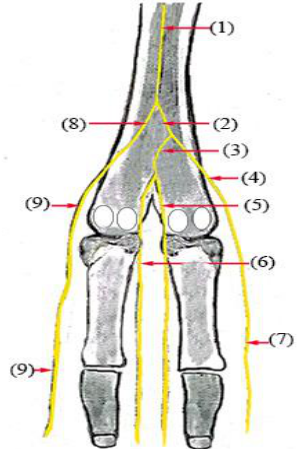
Figure 6. Nerve supply of the plantar surface of the distal hindlimb in camels: (1) tibial nerve; (2) medial plantar nerve of the IV digit; (3) axial plantar proper digital nerve of the III digit; (4) abaxial plantar proper nerve of the III digit; (5) axial plantar proper nerve of the III digit; (6) axial plantar proper nerve of the IV digit; (7) abaxial plantar proper nerve of the III digits; (8) lateral plantar nerve of the IV digit; (9) abaxial dorsal proper digital IV nerve.